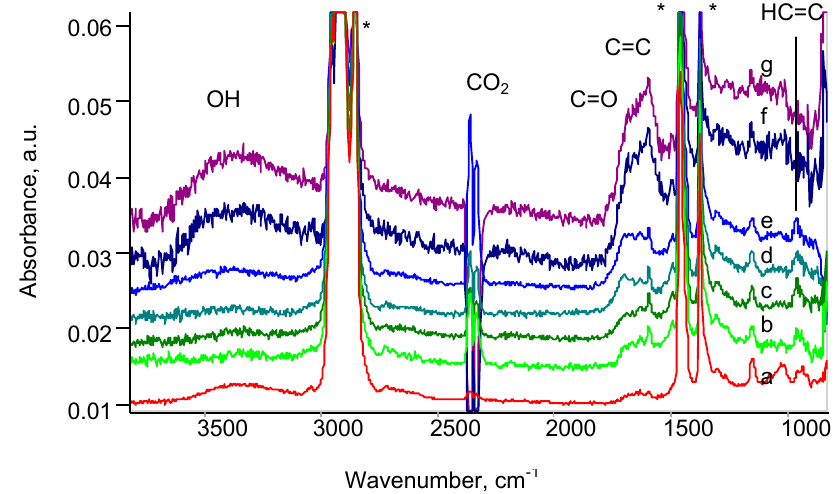
Figure 6. FTIR ATR spectra of EPDM after PIII with different fluence (ions/cm 2 ): ( a ) untreated; ( b ) 10 13 ; ( c ) 10 14 ; ( d ) 5 × 10 14 ; ( e ) 10 15 ; ( f ) 5 × 10 15 ; ( g ) 10 16 . * are the lines of bulk EPDM. “CO 2 ” is a line of carbon dioxide in atmosphere of the FTIR spectrometer.